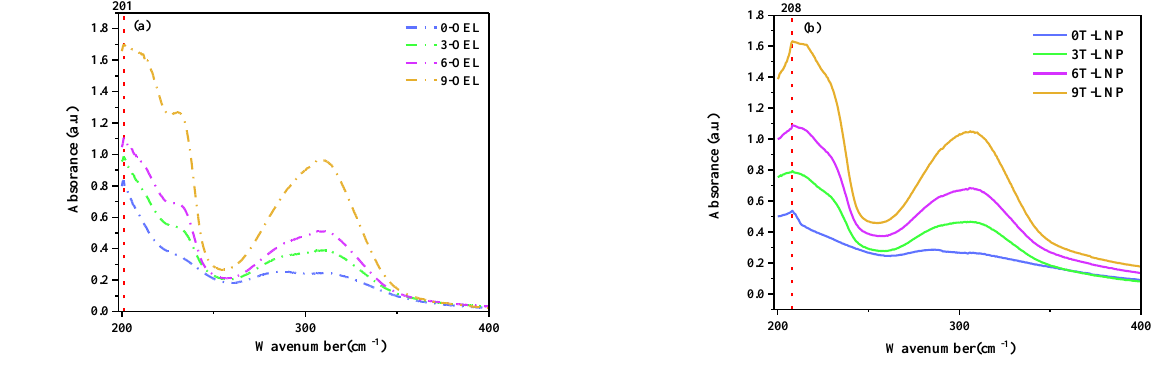
Figure 3. ( a ) UV − vis absorption spectra of OELs and ( b ) T − LNPs.